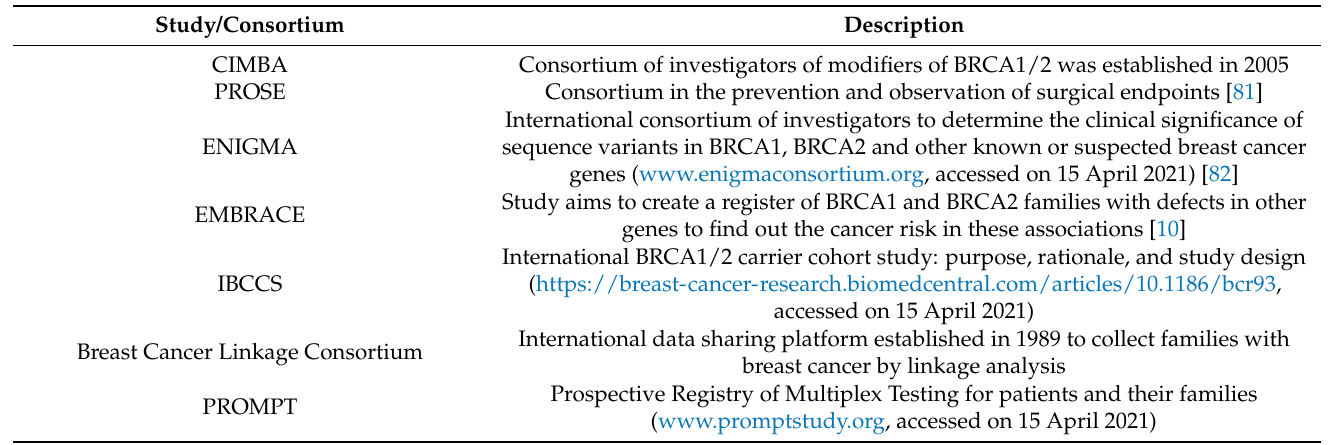
Table 1. International groups investigating BRCA mutations in various populations.